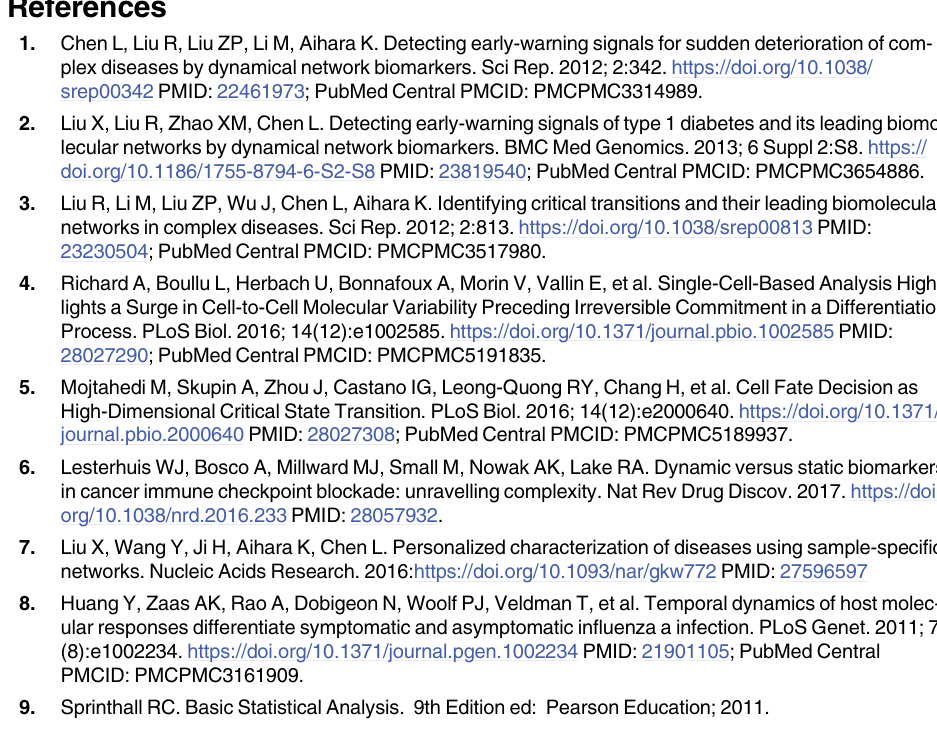
S11 Table. sDNB and early-warning signals based on the other threshold. S12 Table. The overlapped genes among the sDNB with p value of sPCC 0.05 and score of sDNB 1.6. S13 Table. The functional enrichment of the 54 overlapped genes among sDNB with p value of sPCC 0.05 and score of sDNB